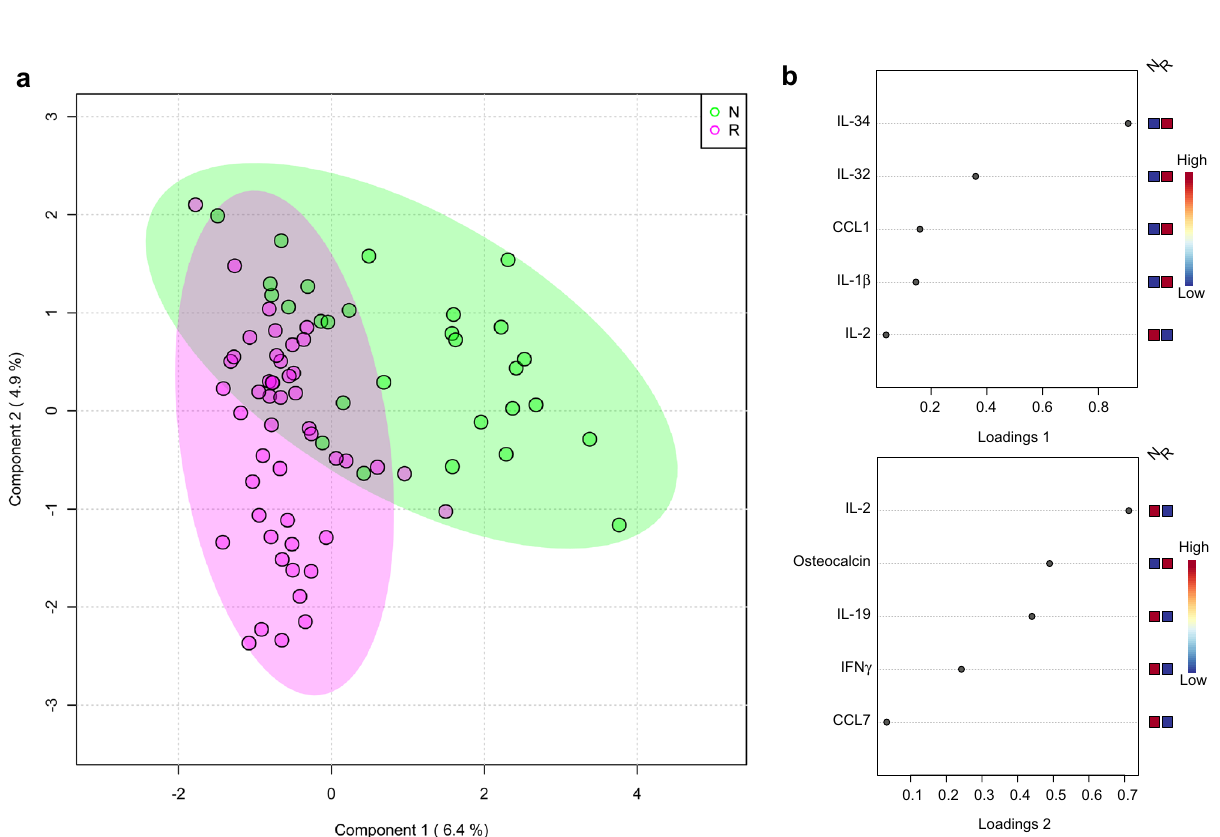
Figure 3. sPLS-DA plot showing model discrimination between relapsed and non-relapsed groups with a partial overlap. ( a ) sPLS-DA 2D plot of the relapsed (R) and non-relapsed (N) groups. ( b ) Loading plot indicating the most discriminating biomarkers of component 1 (upper panel) and component 2 (lower panel) in descending order of contribution. The serum concentration of the analyte was measured in each patient at time points A and F in the sustained remission group and at time points B and C in the relapse group (Fig. 1). The images were created using MetaboAnalyst (ver. 4.0, https:// www. metab oanal yst.